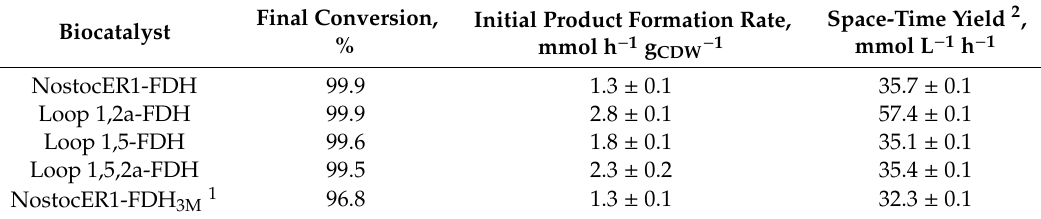
Table 2. Comparison of the generated